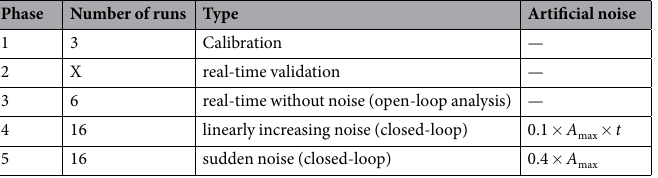
Table 1. Overview on one session of the experimental protocol. Annotations: X – the tests were performed until satisfactory performance was reached (see text for explanation); A max – maximal EMG amplitude in the calibration phase during flexion/extension movements; t –